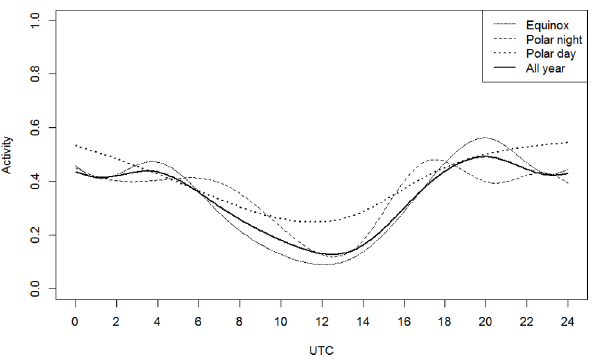
Fig. 4. Lynx activity predicted by the linear mixed additive model for the response variable portion of time spent active per hour during one day (activity) a) throughout the year, and b) subsets of data representing different light conditions. Each covariable is predicted for the reference category adult, female, autumn, Bavaria–Czech Republic, and full moon ( 5 0); therefore, only time influences the